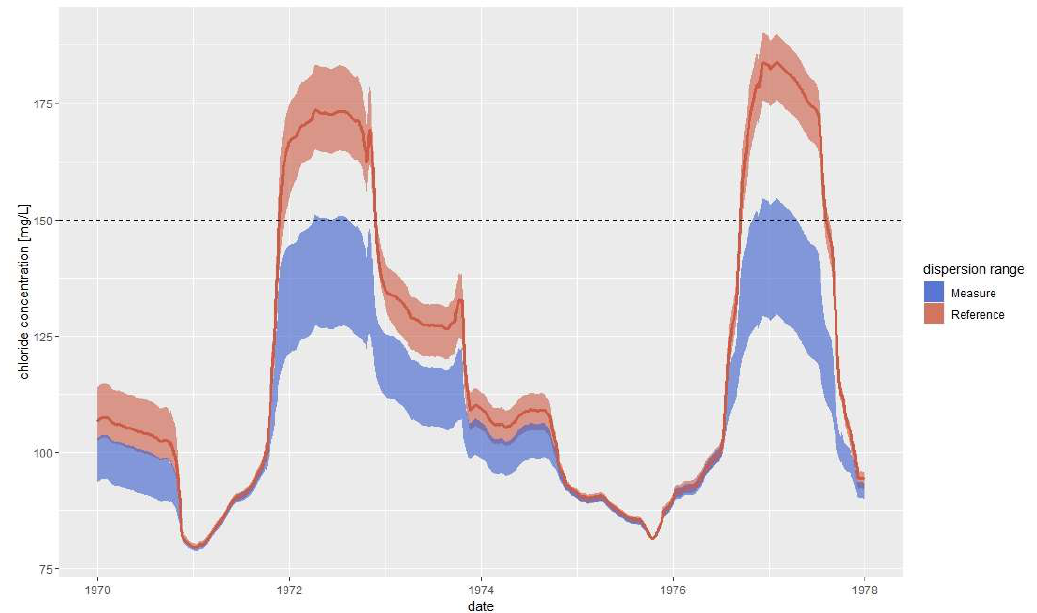
Figure 4. The sensitivity of the 365-day moving average chloride concentration at Streefkerk for the range of the dispersion coefficient: Q up, min = 2 m 3 /s (reference): D = 25–80 m 2 /s (orange); Q up, min = 20 m 3 /s: D = 25–90 m 2 /s (blue).